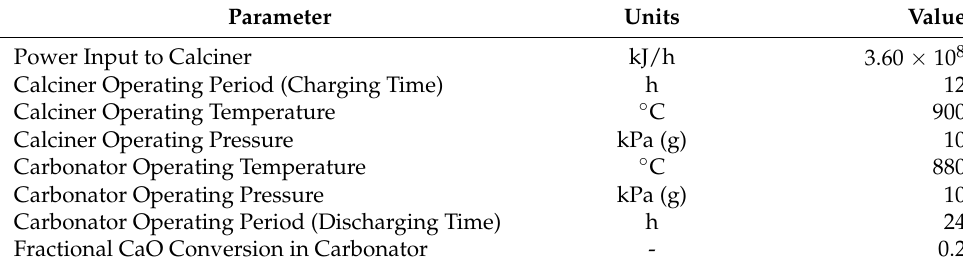
Table 1. Summary of base case process conditions for Configuration